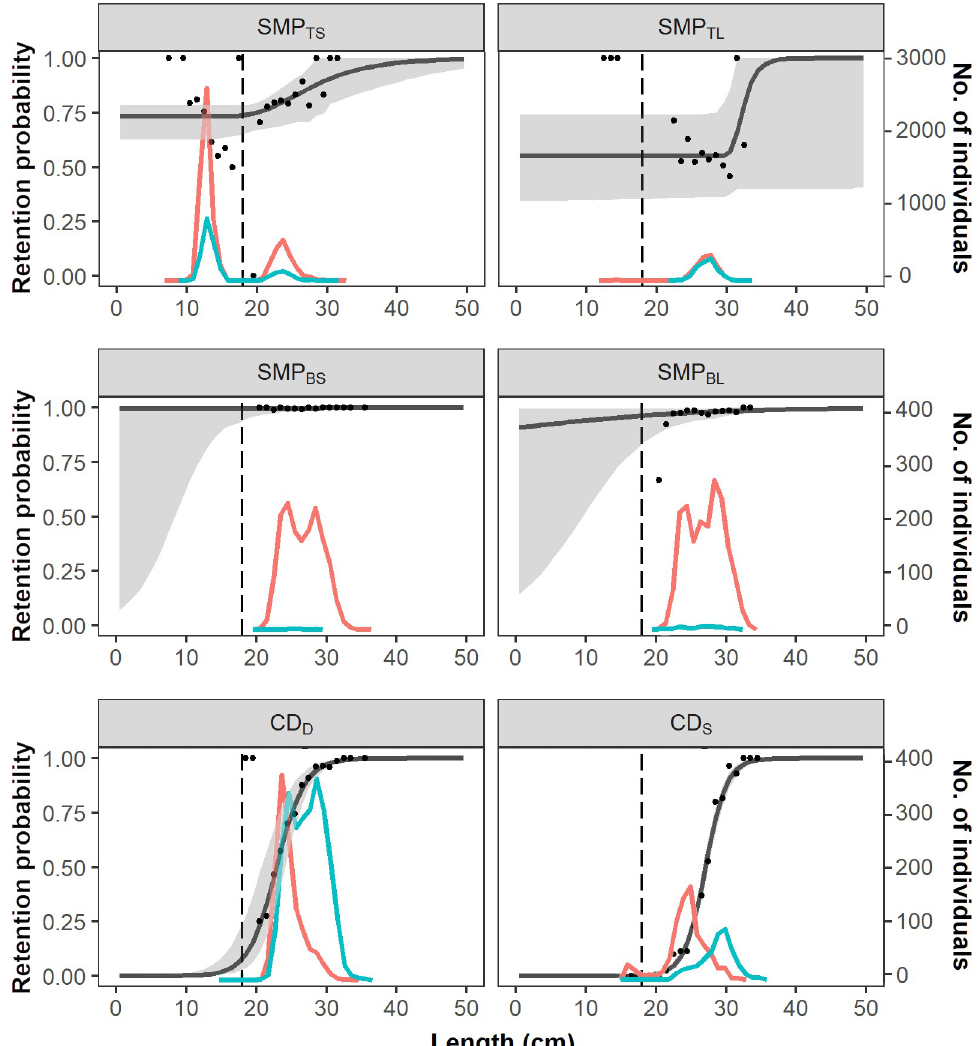
Fig 6. Length-dependent retention probabilities for blue whiting. Retention probability curves (black line) with corresponding CIs (grey bands) and experimental rates (black dots) for the different SMP and codend configurations for blue whiting. Vertical dashed lines show the minimum marketable size for blue whiting: 18 cm. The number of individuals escaped (red lines) and retained (blue lines) by each gear are also shown.